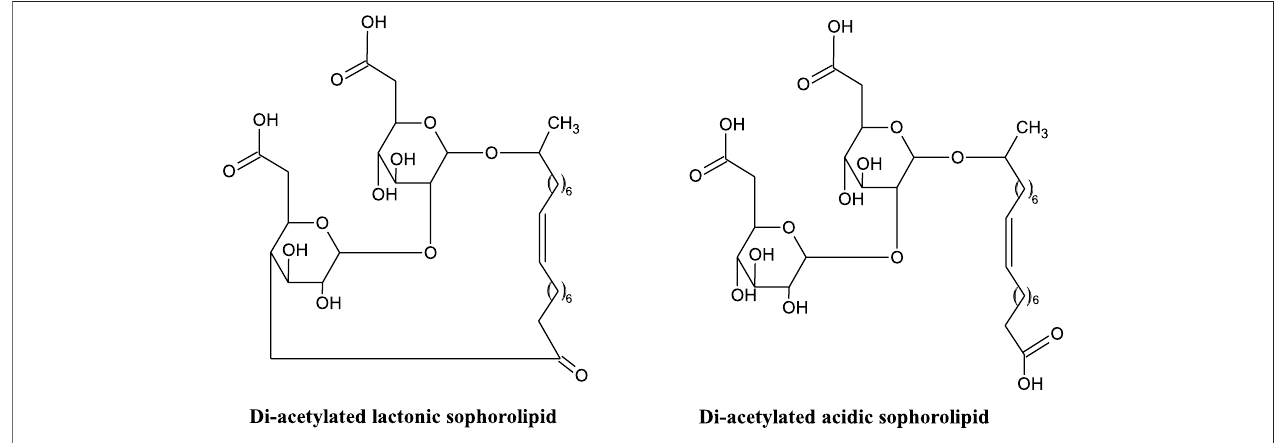
FIGURE 1 | Structure of di-acetylated lactonic and acidic sophorolipids (Hardin et al., 2007; Jezierska et al., 2018).